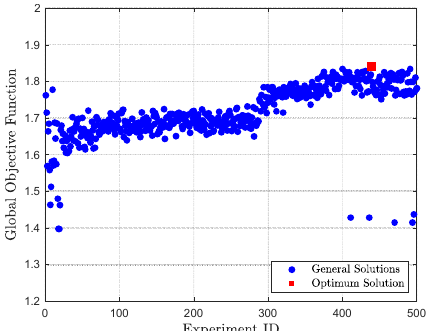
Figure 16. Evolution of the global objective function as the optimization algorithm tries to find an optimum solution.